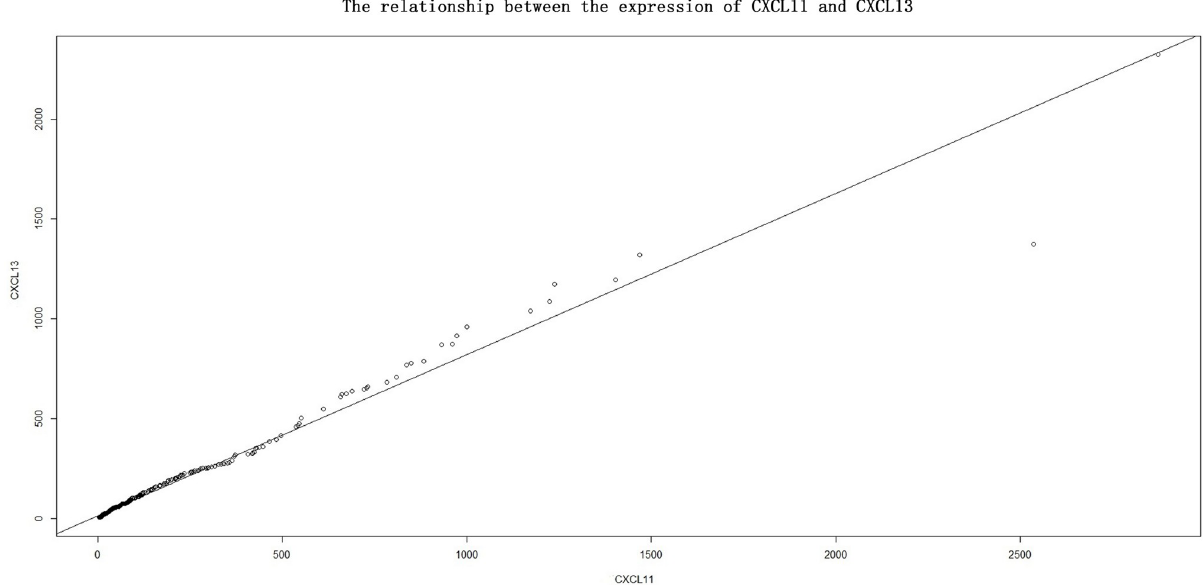
Fig 5. The relationship between the expression of CXCL11 and